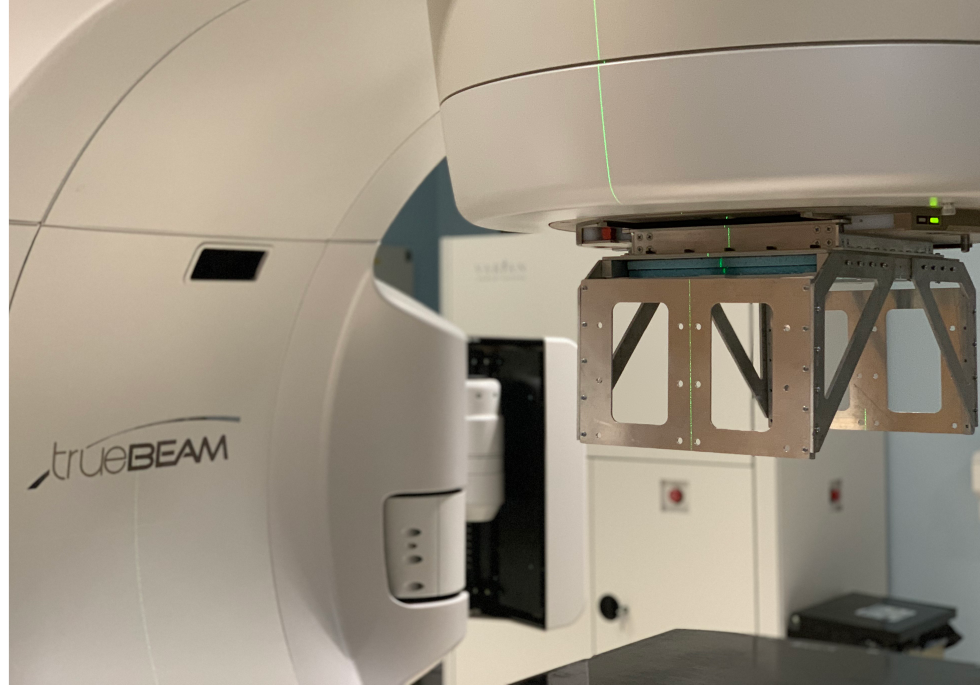
Figure 1. A closeup of the demonstrator device attached to the head of a Varian trueBEAM LINAC. The device is securely attached to the exit window of the LINAC head. The two blue foam layers used to protect the MAPS can be seen. The sensors are in between the two foam layers. The aluminium frame is designed to house the readout electronics (not included here), which is mounted outside of the